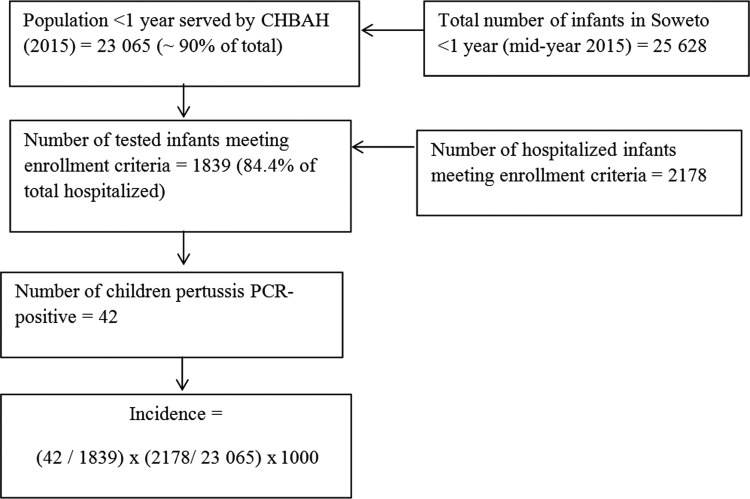
Flowchart of study enrollment at Chris Hani Baragwanath Academic Hospital (CHBAH) and methods for estimating population-based incidence of pertussis polymerase chain reaction (PCR)–positive associated hospitalizations and deaths overall. Incidence estimates were calculated separately for human immunodeficiency virus (HIV)–exposed and HIV-unexposed infants.